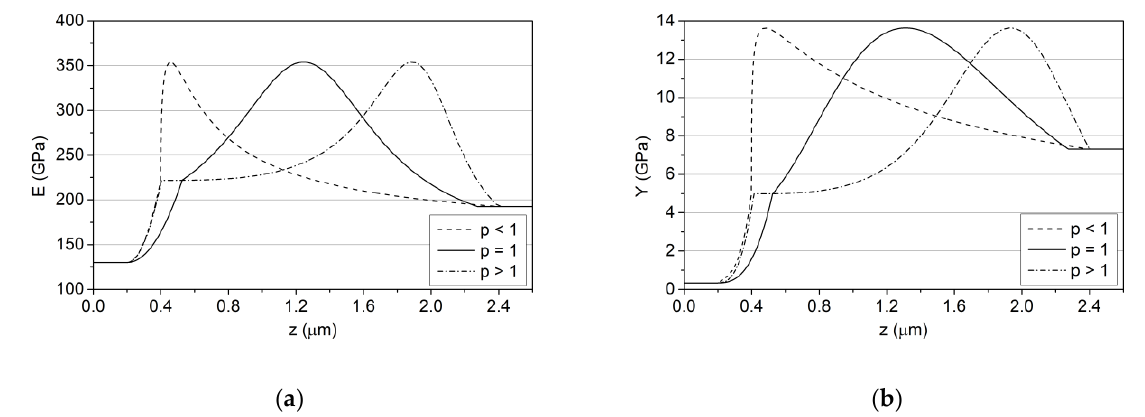
Figure 9. Spatial distributions of the Young’s modulus ( a ) and yield strength ( b ) for selected prototypes ( p < 1, p = 1, p > 1).